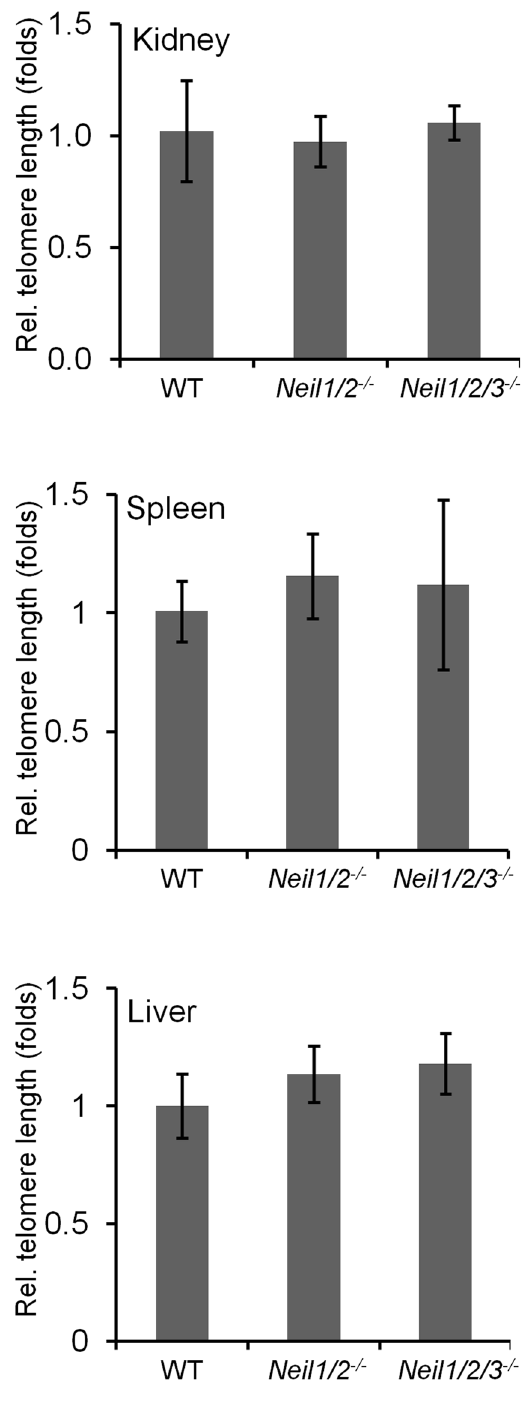
Figure 3. Quantitative analysis of telomere length. Relative telomere length was assessed in kidney, spleen and liver tissue isolated from three individual animals using qPCR in 2 year-old Neil1 − / − /Neil2 − / − and Neil1 − / − / Neil2 − / − /Neil3 − / − tissue compared to WT. Telomere length (mean ± SD) was presented relative to a single copy gene (36B4). Neil1/2 − / − : Neil1 − / − /Neil2 − / − ; Neil1/2/3 − / − : Neil1 − / − /Neil2 − / − /Neil3 − / −